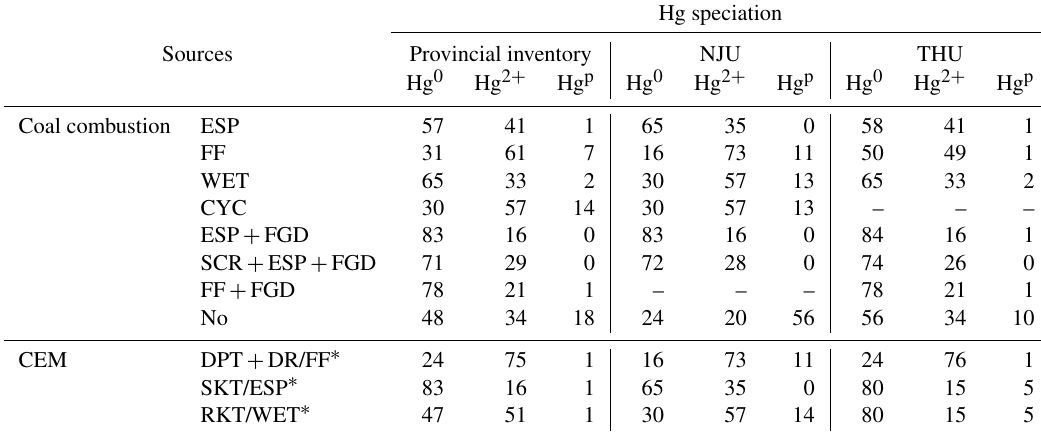
Table 3. Hg speciation profiles used in provincial and national inventories for typical APCDs (%).